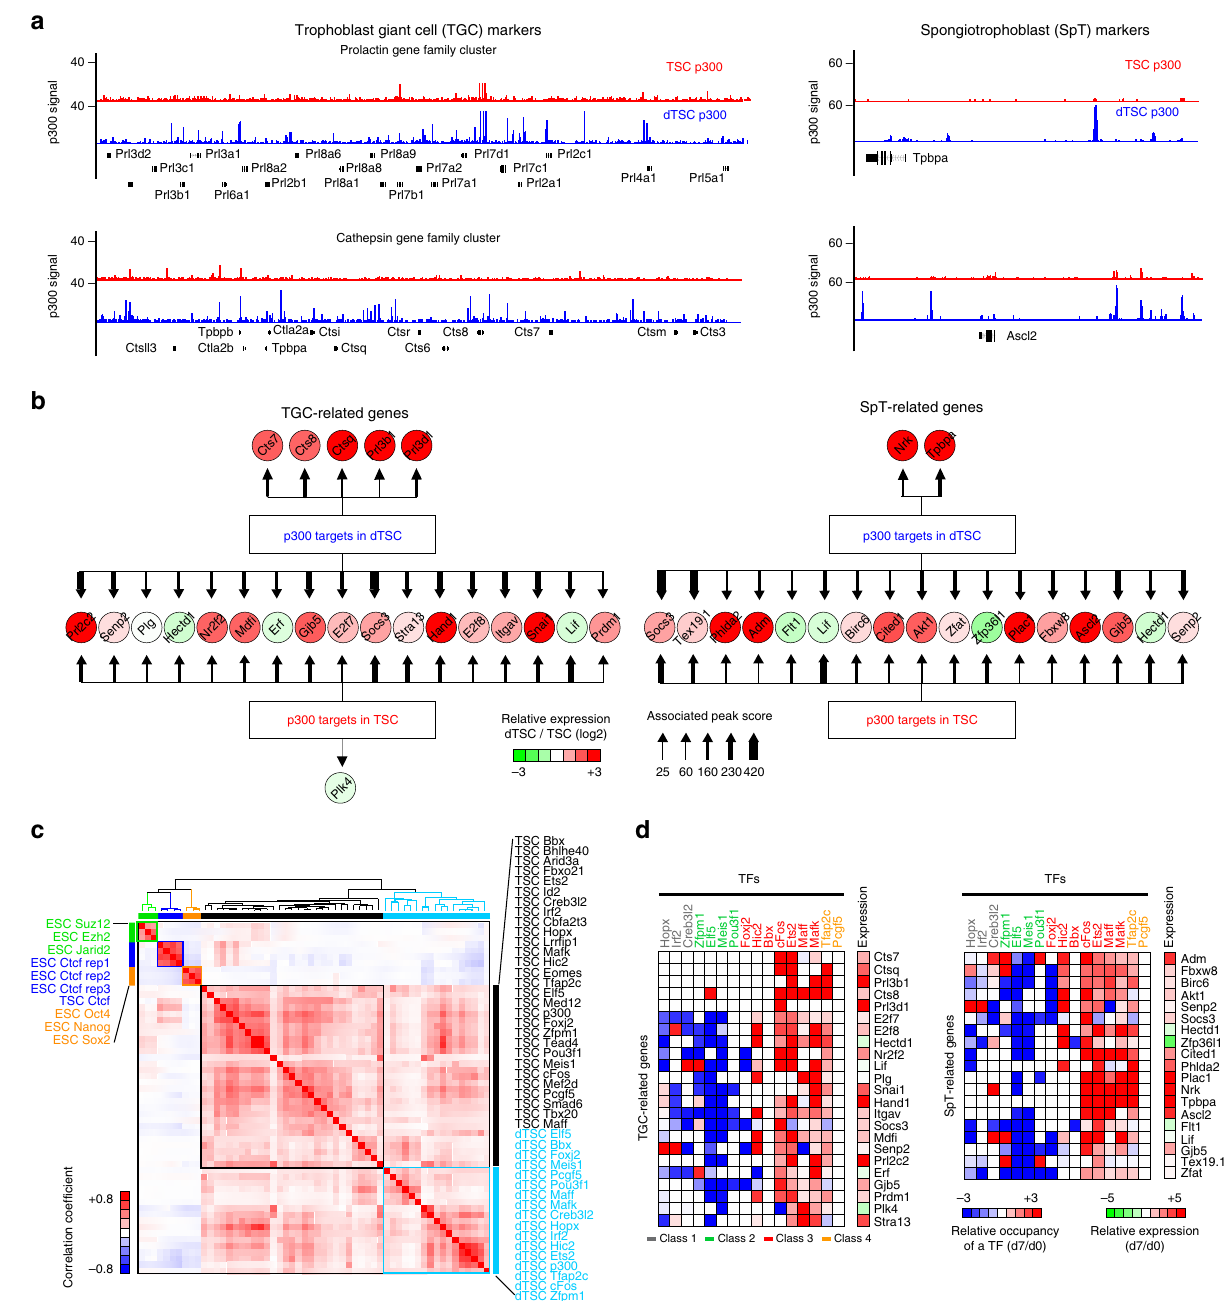
Fig. 4 Dynamic changes of enhancers ’ landscape and occupancy of TSC-speci fi c TFs during differentiation of TSCs. a Signal track images depicting occupancy of p300 around TGC (left panel) and SpT (right panel) markers in TSCs (red) and dTSCs (blue). b p300 occupancy networks of TGC (left panel) and SpT (right panel) marker genes in TSCs and dTSCs. Thickness of an arrow indicates occupancy score of p300. Relative gene expression (dTSCs/TSCs) is shown with color-coded heatmap. c A correlation heatmap of various TFs ’ occupancy. Different functional classes of genes are color coded (Ctcf: blue; pluripotency factors: orange; PRC complex: green; TFs in TSCs: black; TFs in dTSCs: sky blue). Gradient color scale bar on the left indicates correlation coef fi cients. d Heatmaps depicting relative occupancy of TFs (dTSCs/TSCs) in TGC-related (left panel) and SpT-related (right panel) genes. Relative gene expression level (dTSCs/TSCs) is shown right beside the